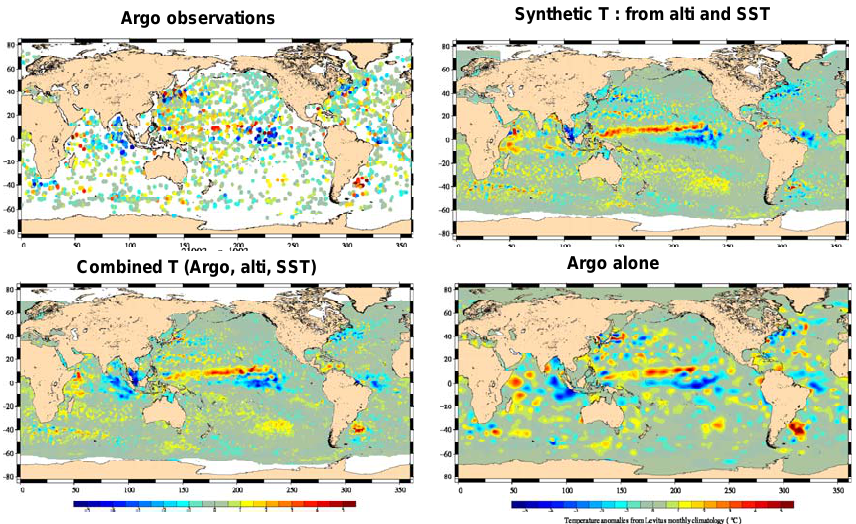
Fig. 8. Use of Altimetry, SST and Argo observations to reconstruct 3-D mesoscale temperature fields. Temperature field at 200m (in ◦ C) at a given day derived from SST and altimeter observations (upper right), Argo observations alone (lower right) and combined Argo, altimeter and SST observations (lower left). Argo observations are shown on the upper left panel (from Guinehut et al.,